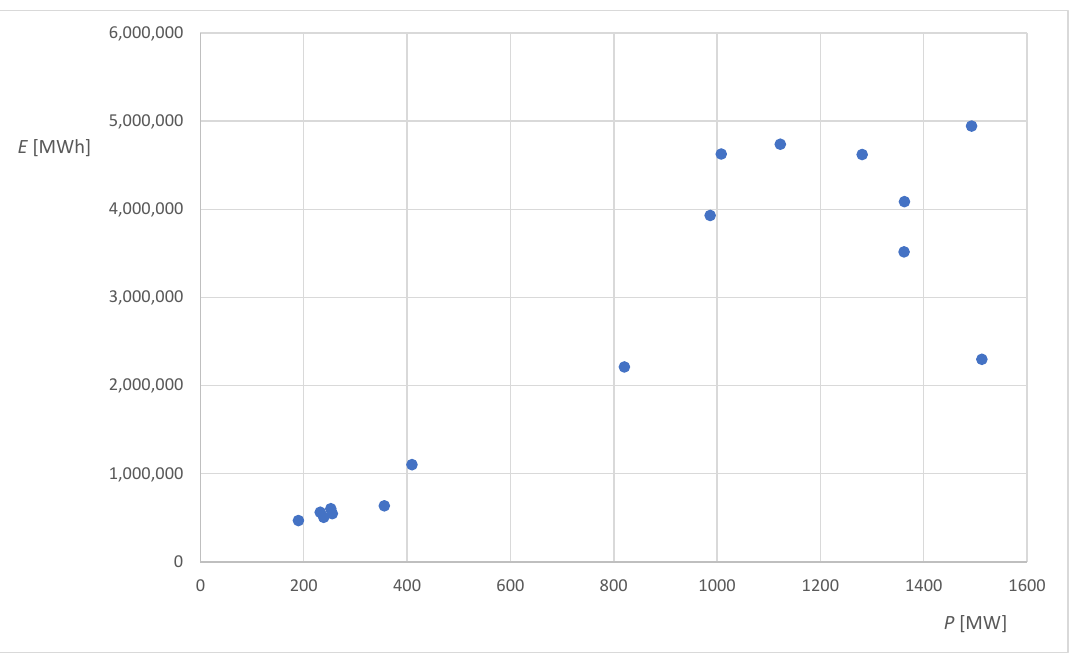
Figure 8. Relationship between the installed capacity derived from biomass and the amount of electricity generated from it in Poland (own elaboration). The highest ratio of the amount (Figure 9) of power obtained from biogas plants per area unit is found in the Warmian-Masurian, Greater Poland, West Pomeranian and Maso- vian regions. The Lesser Poland region, Subcarpathian region and, to a lesser extent, Pom- eranian Voivodship are unfavorable in this classi fi cation. This state of a ff airs can be at- tributed to the unfavorable topography (mountainous areas characterized by a more se- vere climate). The case of Pomeranian Voivodeship can be explained by the intensi fi cation of wind energy.